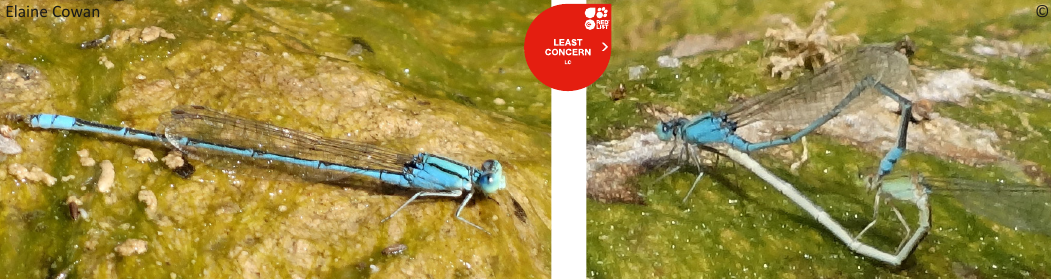
Image 5. Male Pseudagrion decorum , 2 January 2014 . Pale blue eyes, blue-greenish antehumeral stripes. Segments 8 and 9 dorsally blue. Rest of abdomen dark above but pale blue on sides below. Light-coloured